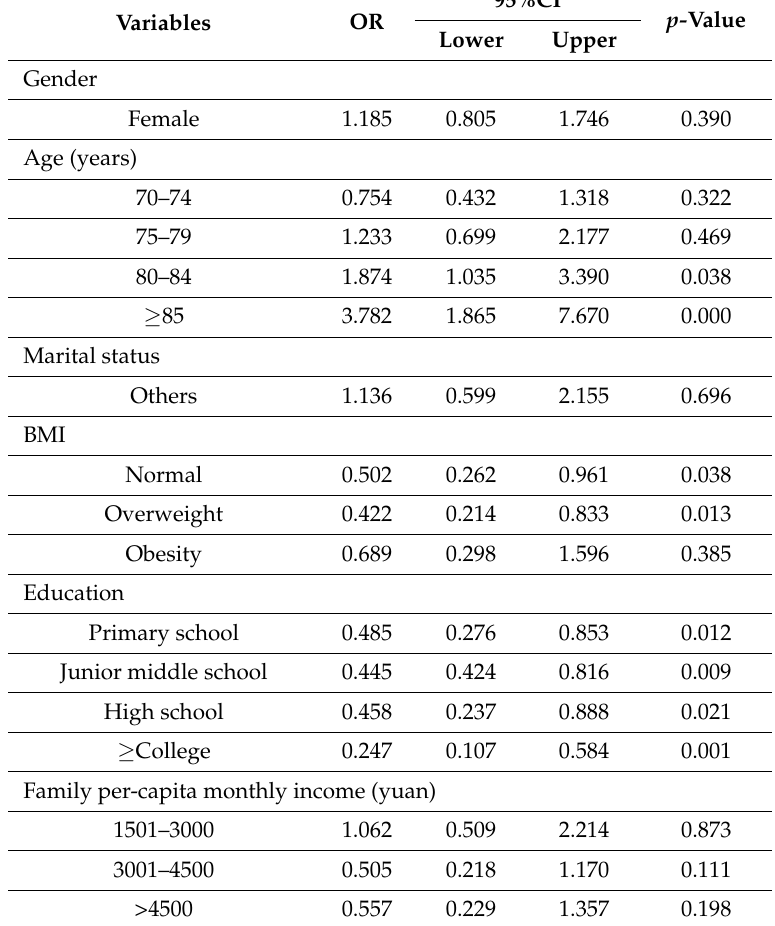
Table 4. Associations between demographic characteristics and the combination of MCI and